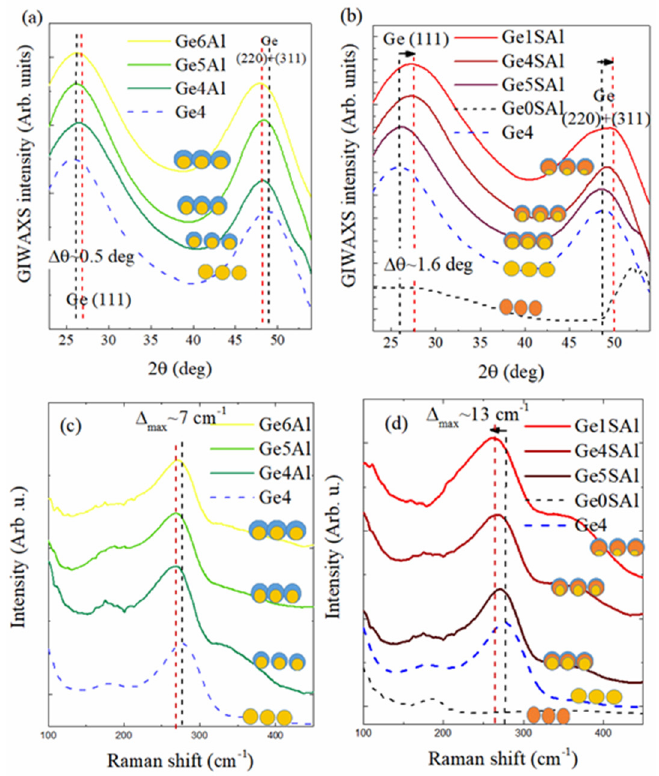
Figure 2. ( a , b ) GIWAXS patterns of the investigated films. The black dashed line indicates the positions of the Ge (111) and Ge (220 + 311) peaks for the material without added shells (Ge4), while the red dashed line stands for the maximally shifted peak positions of the same Ge–related reflections. ( c , d ) Raman spectra of the same films. The arrows indicate the direction of the peak shift. The symbols show schematic images of different QD structures that appear in the investigated films.